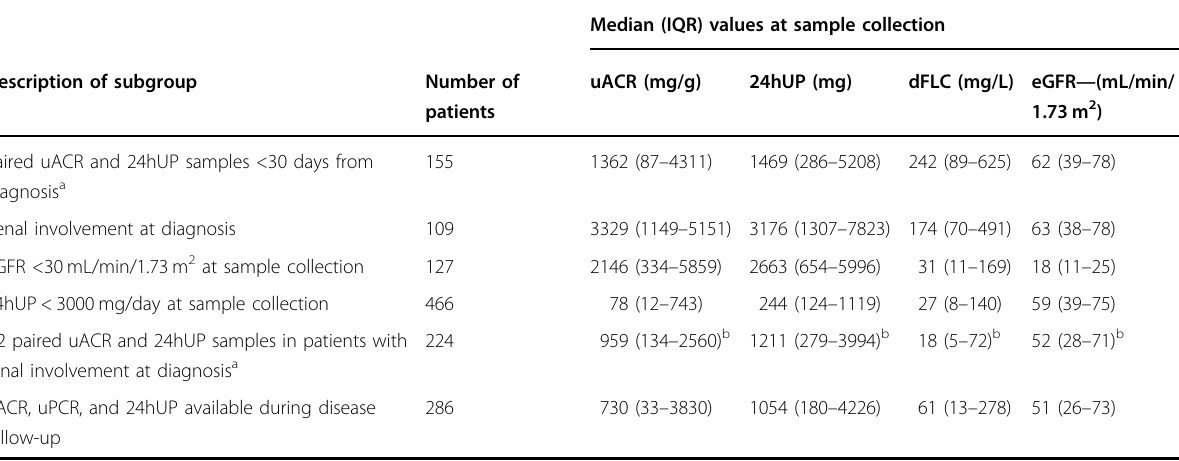
Table 2 Summary of systemic AL amyloidosis patients ( n = 575) included in subset analyses.